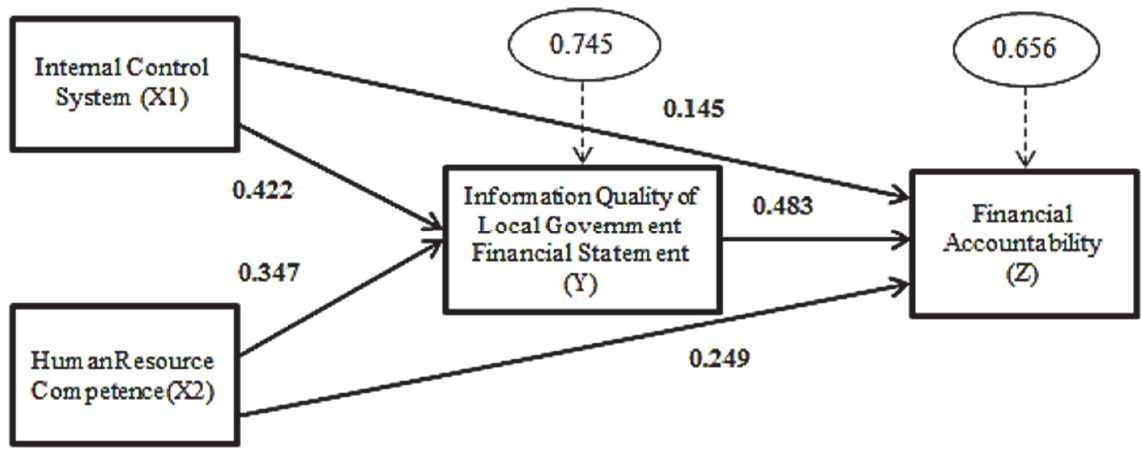
Fig. 1. The results of the testing different